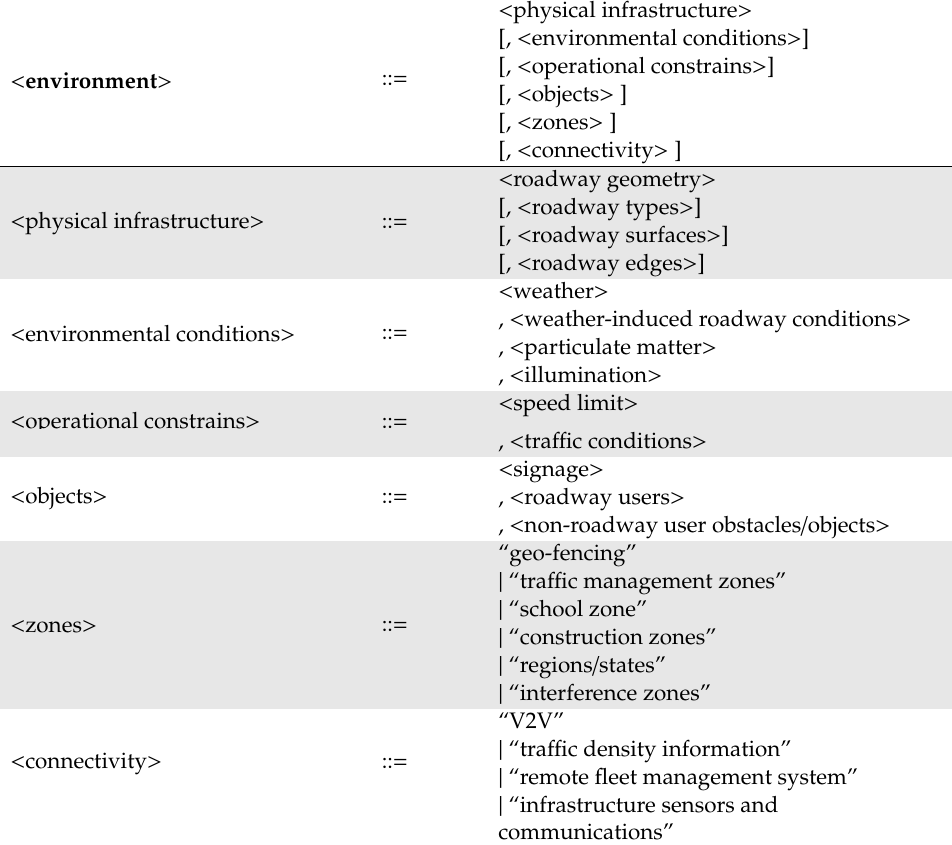
Table A3. The 1st and 2nd stages of < environment >